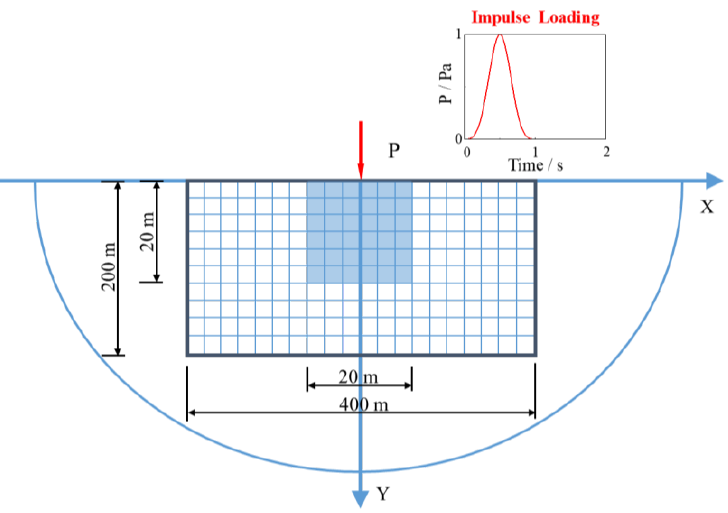
Figure 7. Computational model under impulsive